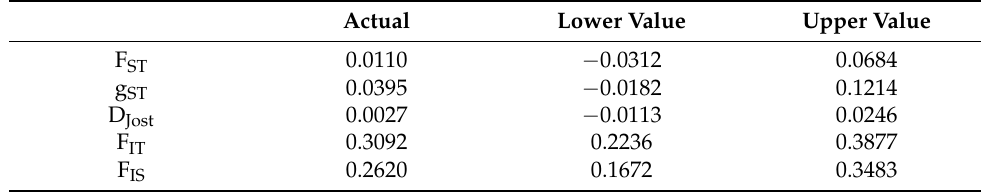
Table 5. Global genetic differentiation values.